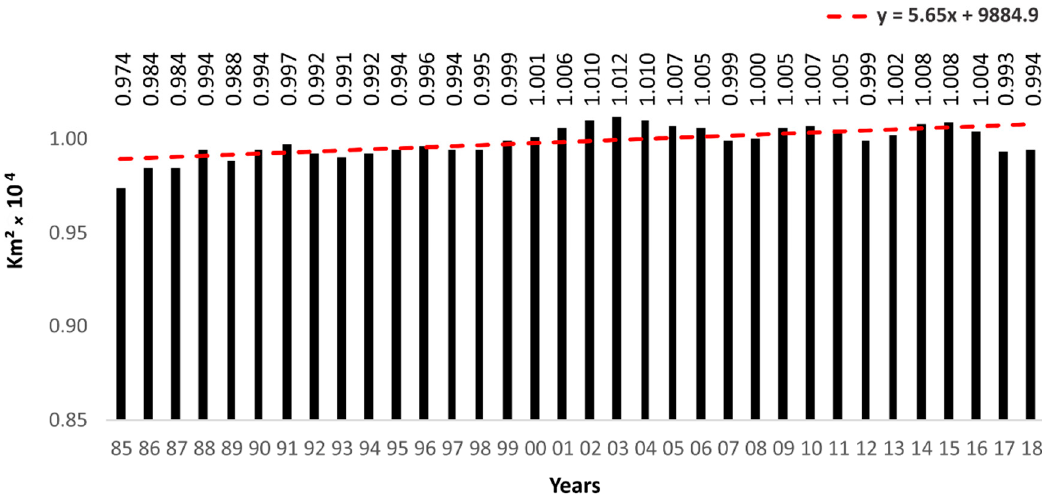
Figure 7. Brazilian mangrove areas from 1985 to 2018. The x -axis represents the years of the study. The y -axis represents total area of Brazilian mangroves in ten thousand kilometers squared. The numbers above each bar are the area values for that bar.